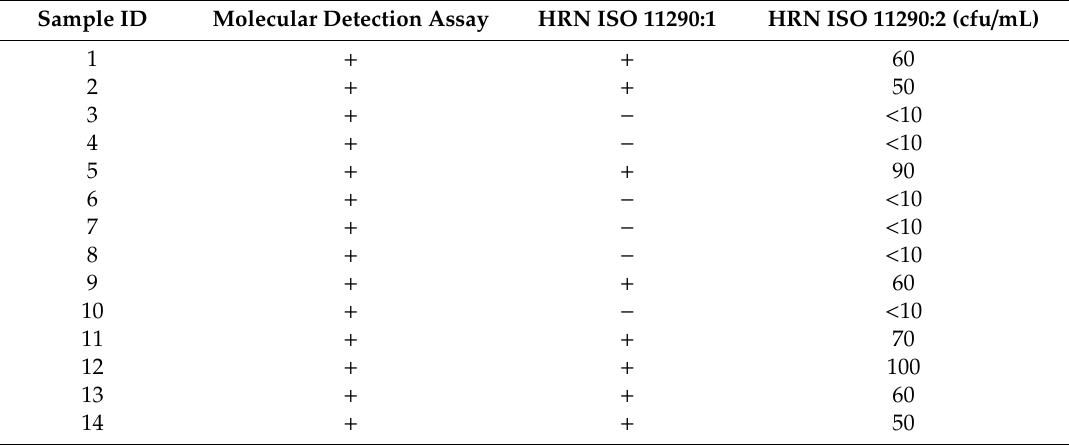
Table 1. Comparison of L. monocytogenes detection results in milk samples by cultural and molecular methods